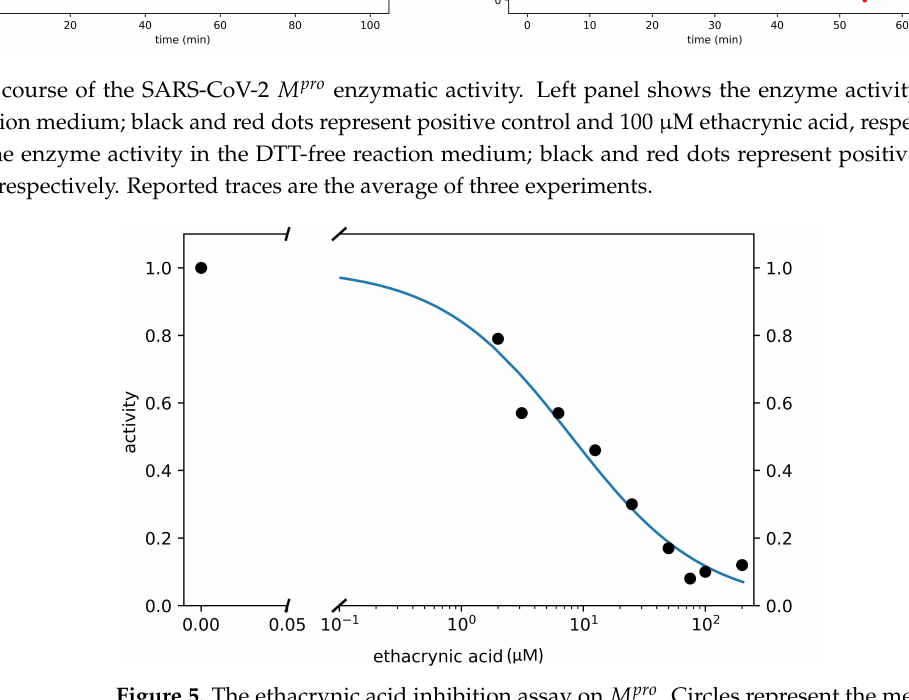
Figure 5. The ethacrynic acid inhibition assay on M pro . Circles represent the mean of at least three independent replicates. Hill-type fitting curve described in the main text is also